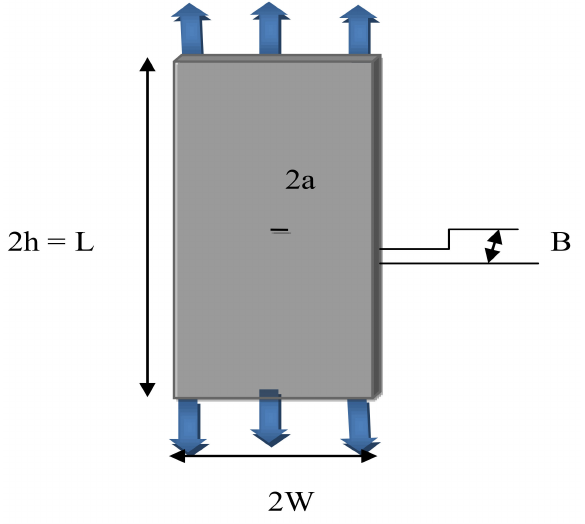
Figure 2. Specimen configuration with a centered crack of length 2a